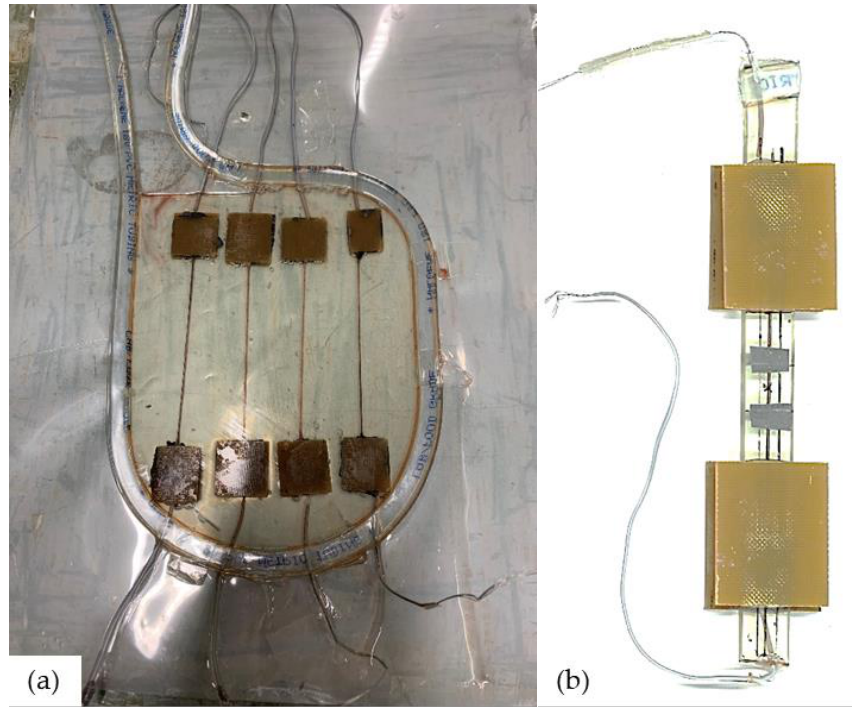
Figure 2. ( a ) Overview of the coated regenerated cellulose fiber (CRCF) tows embedded in epoxy resin at the manufacturing and an ( b ) example of the tabbed specimen of the model composite. Strain–electrical resistance test: A single-tow composite was tested for change in electrical resistance under applied mechanical loading. Samples attached to wires were connected to a reference 3000 Potentiostat/Galvanostat (Gamry Instruments Inc,